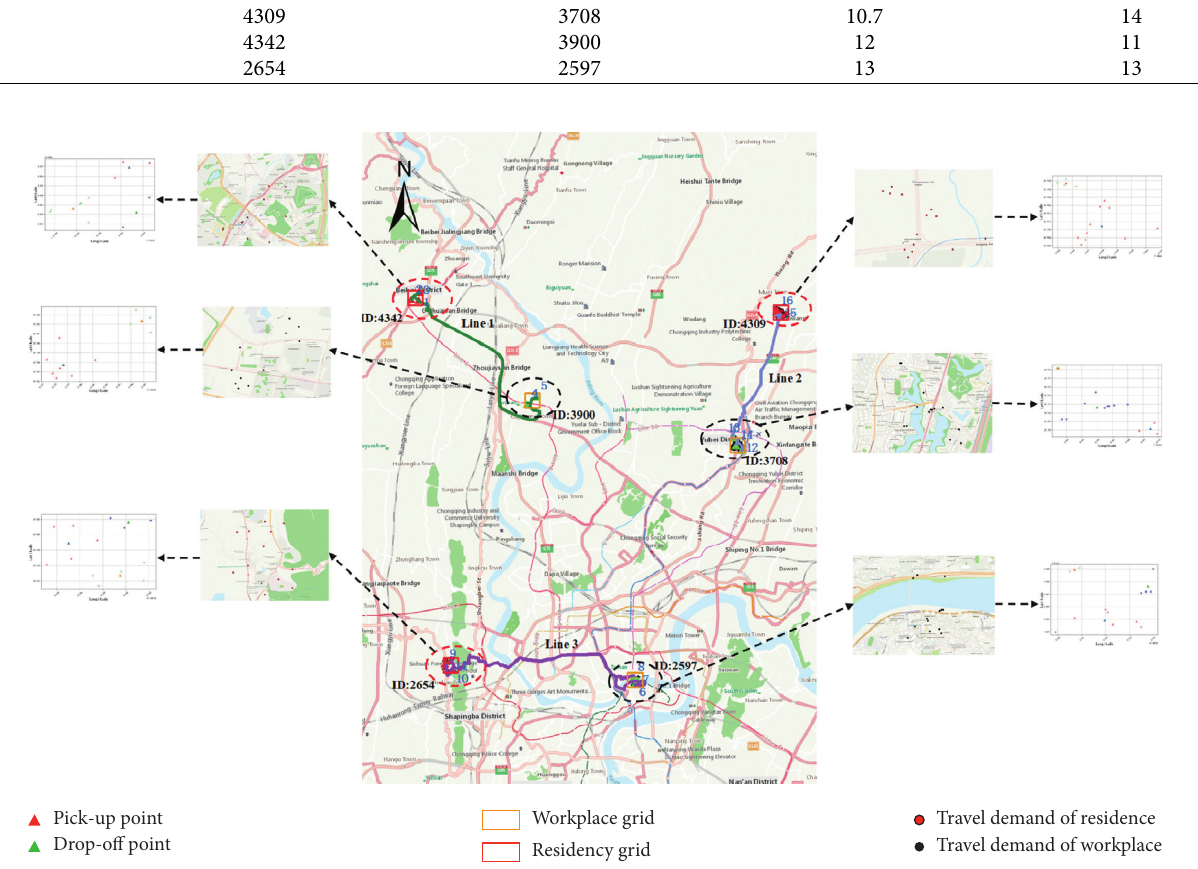
Figure 6: Example of line